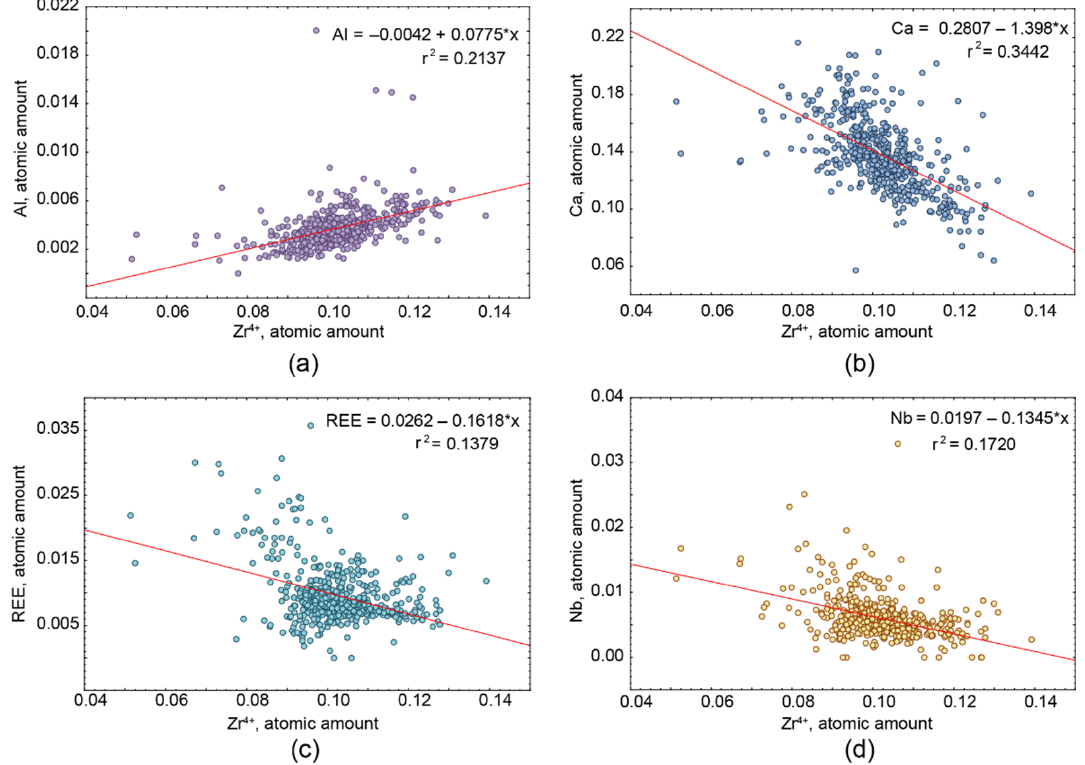
Figure 7. The relations between the cation contents in EGMs from Alluaiv Mt.: ( a ) plot Al 3+ vs. Zr 4+ , ( b ) plot Ca 2+ vs. Zr 4+ , ( c ) plot REE 3+ vs. Zr 4+ , ( d ) plot Nb 5+ vs. Zr 4+ . The marginal zones of EGM grains with the small excess of Zr (0.2 apfu) or non-zonal grains with normal Zr-content (3 apfu) crystallize in the R 3 m space group with additional